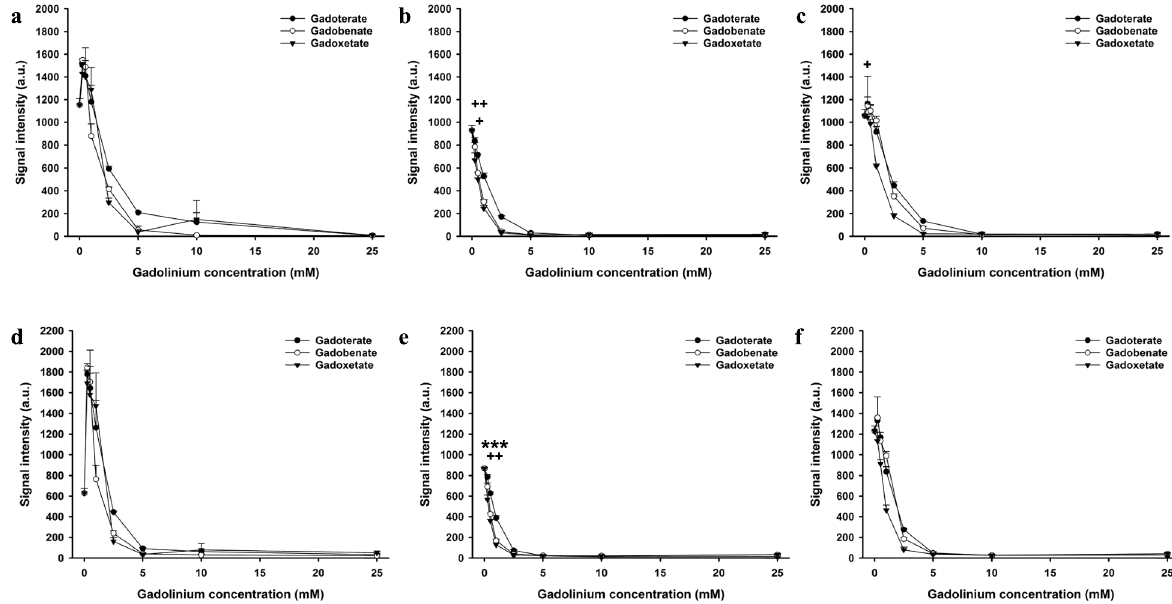
Fig. 6 Signal intensities of gadoterate, gadobenate, and gadoxetate in saline and biological fluids on T2‑weighted TSE and fluid‑attenuated (FLAIR) sequence. Signal intensities of gadoterate, gadobenate, and gadoxetate at different concentrations in saline ( a ), blood ( b ), and bile ( c ) on T2‑weighted turbo spin‑echo MRI. Signal intensities of gadoterate, gadobenate, and gadoxetate at different concentrations in saline ( d ), blood ( e ), and bile ( f ) on FLAIR sequence. * significantly higher maximum signal intensity of the contrast agent than both other contrast = agents; significantly higher maximum signal intensity than the contrast agent with the lowest maximum signal intensity. * or + = or p < 0.010; *** or p < + + = + + + =